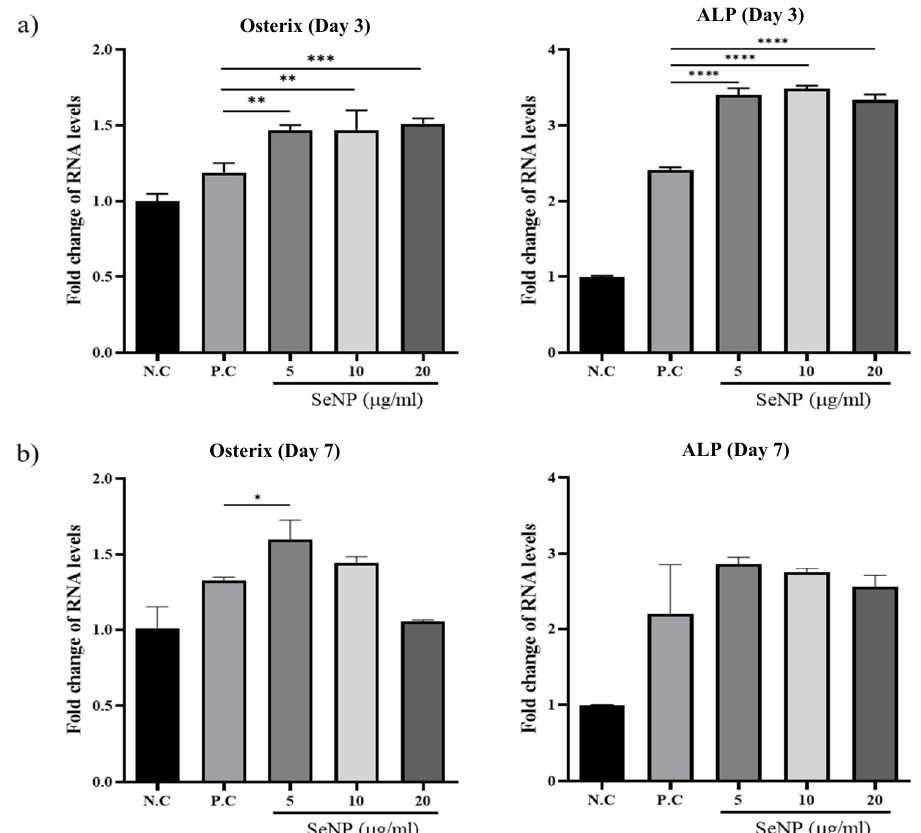
Figure 5. The effect of SeNPs on the expression of osteogenic genes through qRT-PCR. The relative expression levels of target genes normalized to GAPDH were calculated using the delta cycle threshold (Ct) method. The figure shows the relative expression of multiple genes relative to gene expression in the negative control treatment cells. ( a ) Results of qRT-PCR analysis of osteogenic markers on the third day after treatment with osteogenic differentiation media. In the group treated with selenium, the activities of osterix and ALP were higher than those in the group not treated with selenium. ( b ) Results of qRT-PCR analysis on the seventh day after treatment with osteogenic differentiation media. The selenium-treated group showed higher osterix and ALP activity than the selenium-treated group, and the highest gene expression was confirmed at 5 µ g/mL. Statistical significance was calculated using one-way ANOVA followed by a two-sided Dunnett post hoc test compared to CTL (N.C: Negative control, P.C: Positive control). * Represents p < 0.05, ** p < 0.01, *** p < 0.001, **** p < 0.0001; n = 3.